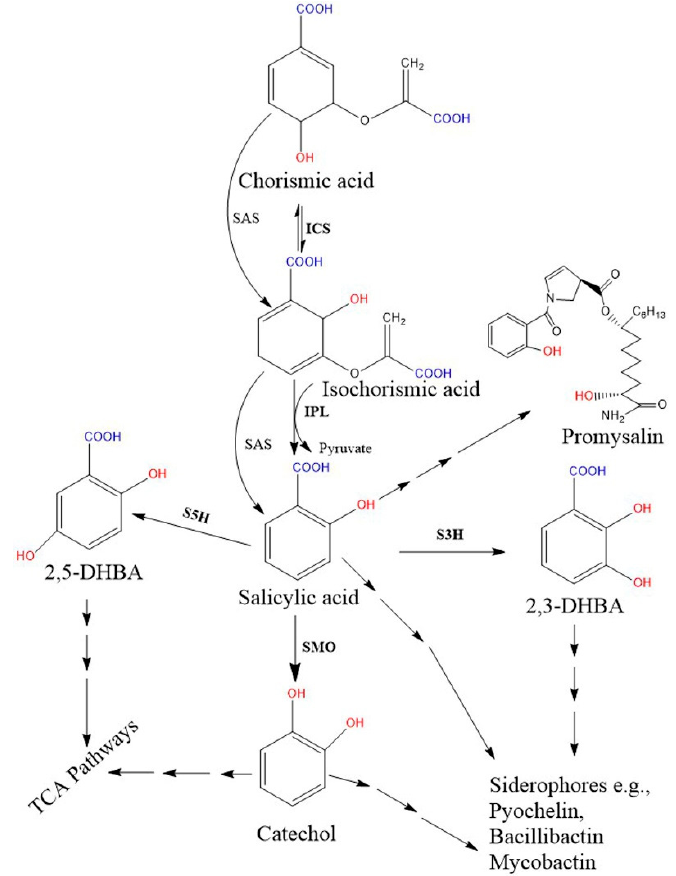
Figure 2. Proposed bacterial pathway for the biosynthesis of SA and their derivative catecholate siderophore. The catecholate siderophore group is only found in bacteria, and their core structures are synthesized from the SA-BGC system. In the Pseudomonas spp., SA is synthesized from chorismate via a two-step enzymatic process ( pchA ; ICS and pchB ; IPL), while the single bifunctional enzyme SAS encoded by MbtI (in Mycobacterium) and Irp9 (in Yersinia) converts chorismate to SA. Further, SMO (also called S1H) converts SA to 1,2-dihydroxybenzene (catechol). Additionally, hydroxylation of SA results in 2,3-DHBA and 2,5 DHBA. Here, salicylate/2, 3-DHBA/catechol can be converted to salicyl-derived siderophores with the help of more than one enzyme. Moreover, catechol and gentisate (2, 5-DHBA) are also metabolized in the TCA pathway. Promysalin, an antibiotic synthesized from SA is also reported in a few Pseudomonas spp. [51]. Solid arrows denote single enzymatic steps, while several arrows denote multiple sequential enzymatic steps. All the demonstrated chemical structures are drawn using the ChemDraw 13.0 software (PerkinElmer, Waltham, MA, USA). Abbreviations: ICS, isochorismate synthase; IPL, isochorismate pyruvate lyase; SAS, salicylate synthase; SMO, salicylate1-monooxygenase; S1H, salicylate 1-hydroxylase; S3H, SA 3-hydroxylase; S5H, salicylate 5-hydroxylase; DHBA, dihydroxybenzoic acid; TCA, tricarboxylic